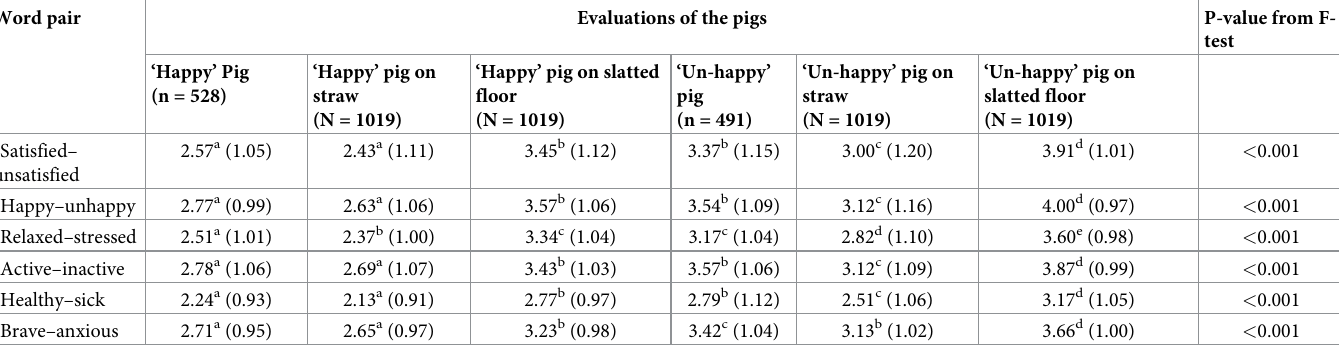
Table 4. Mean comparison using ANOVA and post-hoc tests for the evaluation of the ‘happy’ and the ‘unhappy’ pig presented separately or in the two pens (straw/ slatted floor). Word pair